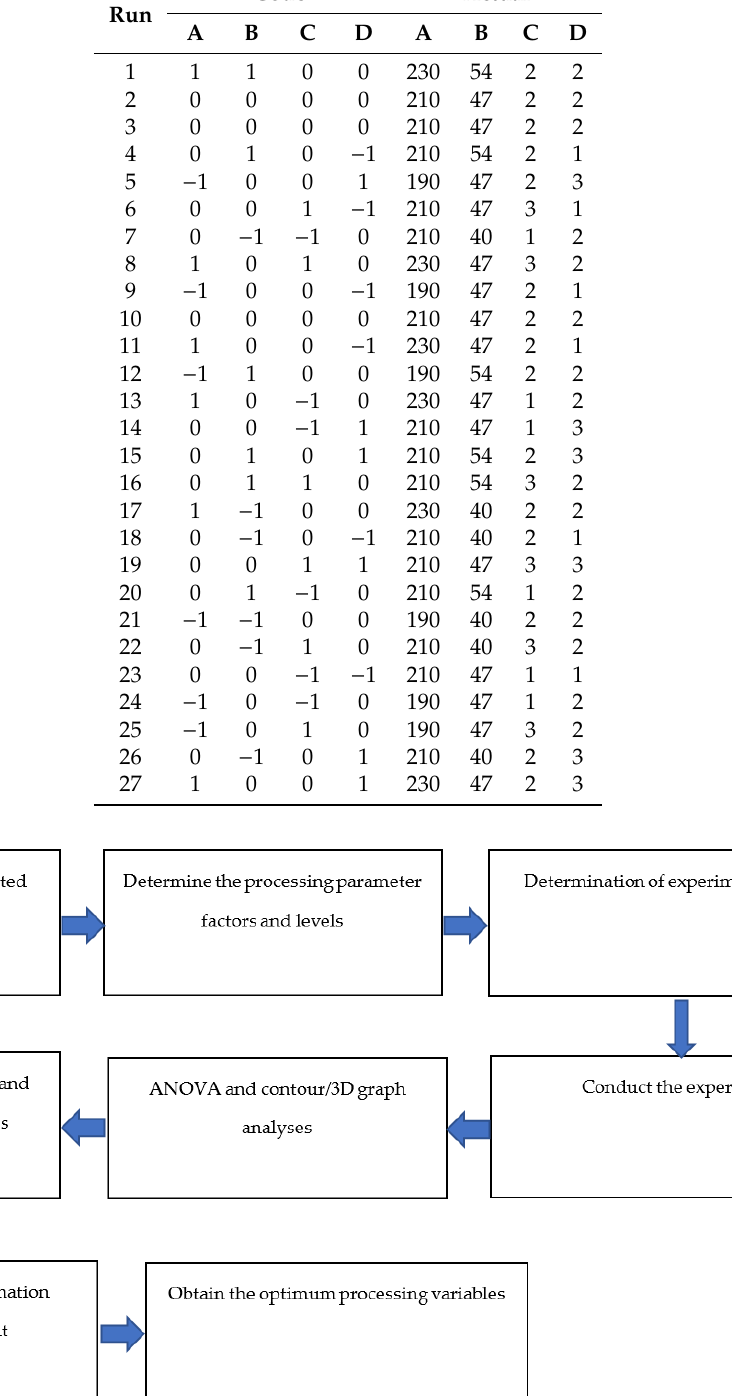
Table 3. Three-level four-factor experimental design.